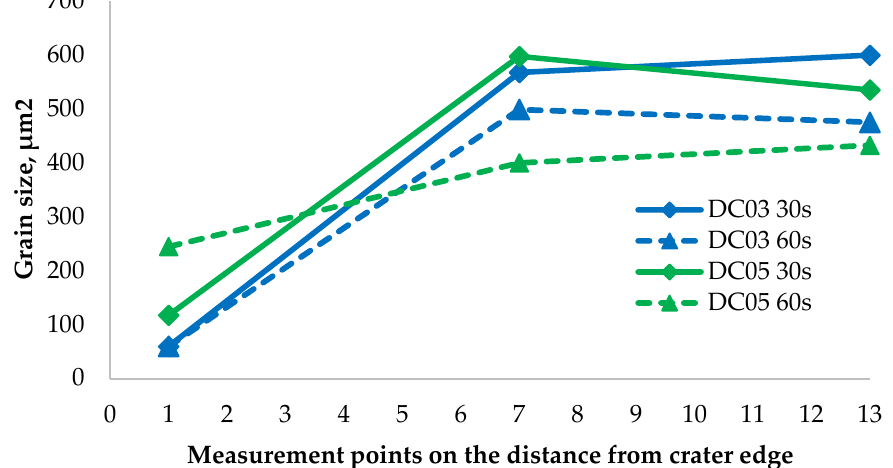
Figure 15. The relationship of the average grain size for measurement points: 1 (2 mm from crater edge), 7 (14 mm from crater edge), 13 (26 mm from crater edge).